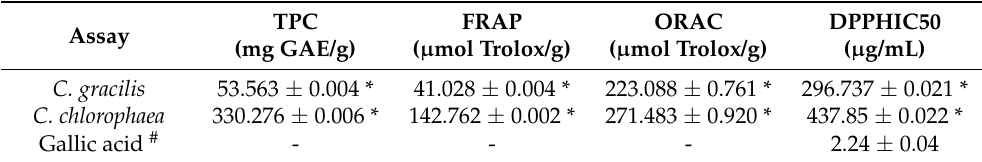
Table 2. Total phenolic content (TPC) and antioxidant activity (FRAP; ORAC; DPPH) of C. gracilis and C. chlorophaea .